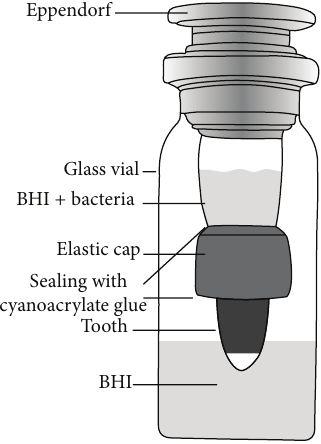
Figure 1: The leakage evaluation